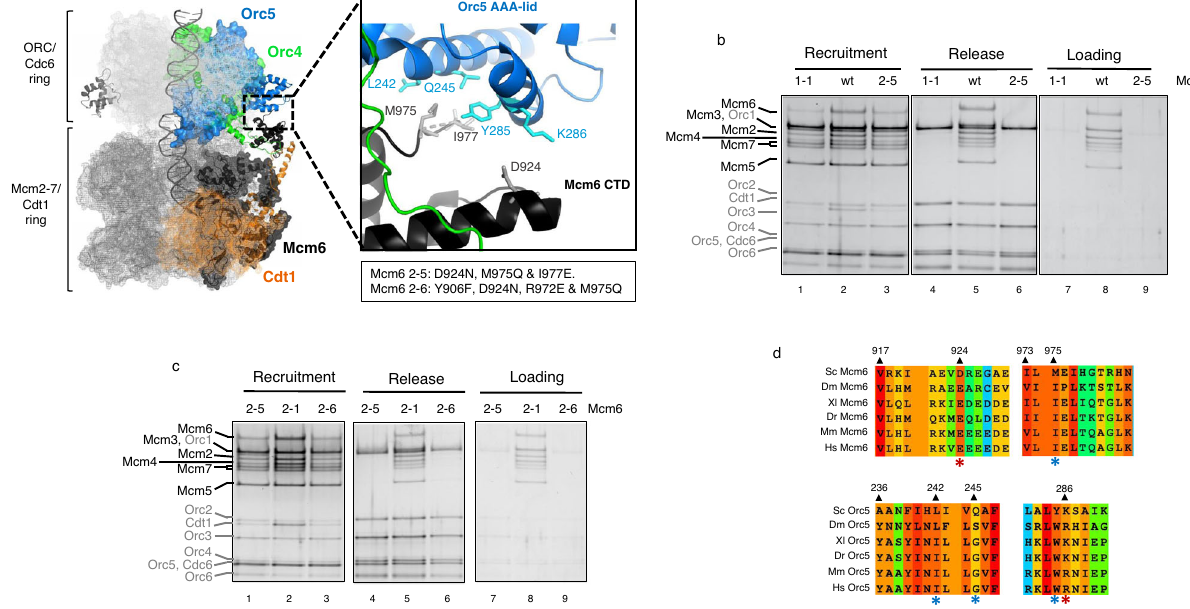
Fig. 6 Interaction with the AAA-lid domain of Orc5 by Mcm6 C-WHD is essential for Cdt1 stabilization of half MCM. a Cryo-EM structure of the OCCM complex 8 . The ORC-Cdc6 ring is illustrated in light grey mesh, while the MCM-Cdt1 ring is in dark grey mesh. The surface of speci fi c individual proteins are highlighted in different colours: Orc 4 (green), Orc5 (blue), Mcm6 (black), and Cdt1 (orange). Of these, the domains studied in this work are further highlighted with their secondary structure, maintaining the colours (extended C-WHD of Cdt1, C-WHD of Mcm6, Orc4 C-WHD and Orc5 AAA lid). Note that the secondary structure of Mcm3 C-WHD is also illustrated in grey. The zoomed area shows in detail the interaction between the Mcm6 C-WHD (in black) and the Orc5 AAA + lid domain (in blue). Side chains of residues studied are depicted in grey (Mcm6) and cyan (Orc5). Speci fi cally, D924 of Mcm6 forms an ionic pair with K286 of Orc5, while M975 of Mcm6 interacts with a hydrophobic patch of Orc5, composed by L242, Q245 and Y285 (Supplementary Fig. 7). In addition, the position of a semiconserved I977 in Mcm6 is also illustrated. The speci fi c amino acid substitutions in Mcm6, containing 2-5 and 2-6 mutations, are detailed in the box. Note that 2-6 mutations include two different mutations already present in 2-1 (Y906 and R972) and in 2-5 mutations (D924 and M975). b PreRC assay with MCM-Cdt1 containing Mcm6 wt, 1-1 and 2-5 mutations. c PreRC assay comparing Mcm6 2-5 and 2-6 mutations. Additionally, Mcm6 2-1 is also included because some mutations present in Mcm6 2-6 are also present in Mcm6 2-1. d Alignment of the residues involved in the interaction between the Mcm6 C-WHD and the Orc5 AAA + -lid. The ionic pairs between Mcm6 D924 and Orc5 K286 are highlighted in red asterisks. The structural conservation between the hydrophobic patch of Orc5 (L242, Q245 and Y285) and Mcm6 M975 is highlighted in blue asterisks. Sc Saccharomyces cerevisiae , Dm Drosophila melanogaster , Xl Xenopus laevis , Dr Danio rerio , Mm Mus musculus , Hs Homo sapiens